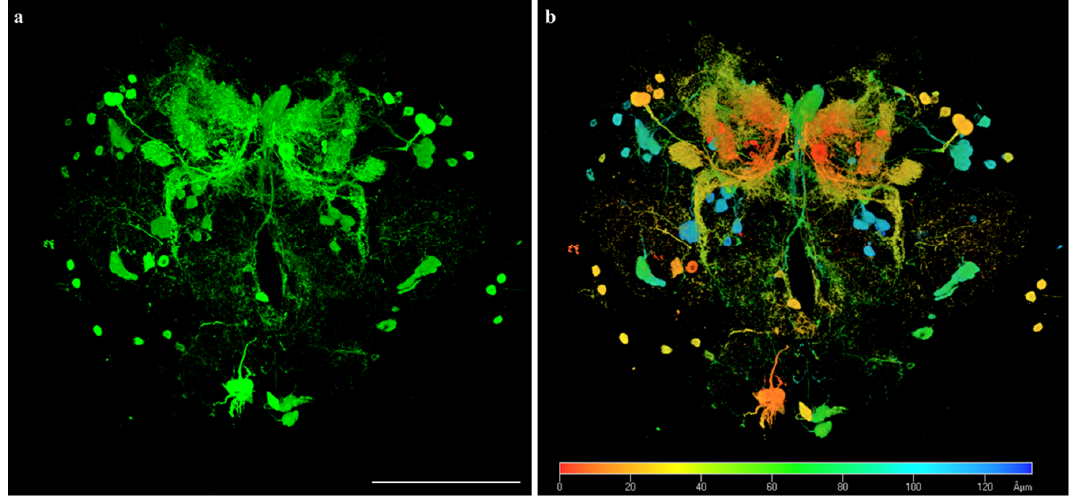
Figure 3. A three-dimensional (3D) optical image of a Drosophila fly brain (TH-gal4 > UAS-GFP) shown in a green fluorescent manner (a) and in depth color (b). In total, 161 optical sections were acquired and projected onto one plane. The scale bar is 100 μm. The depth color bar in panel (b) runs from 0 (red) to greater than 120 (blue) μm.